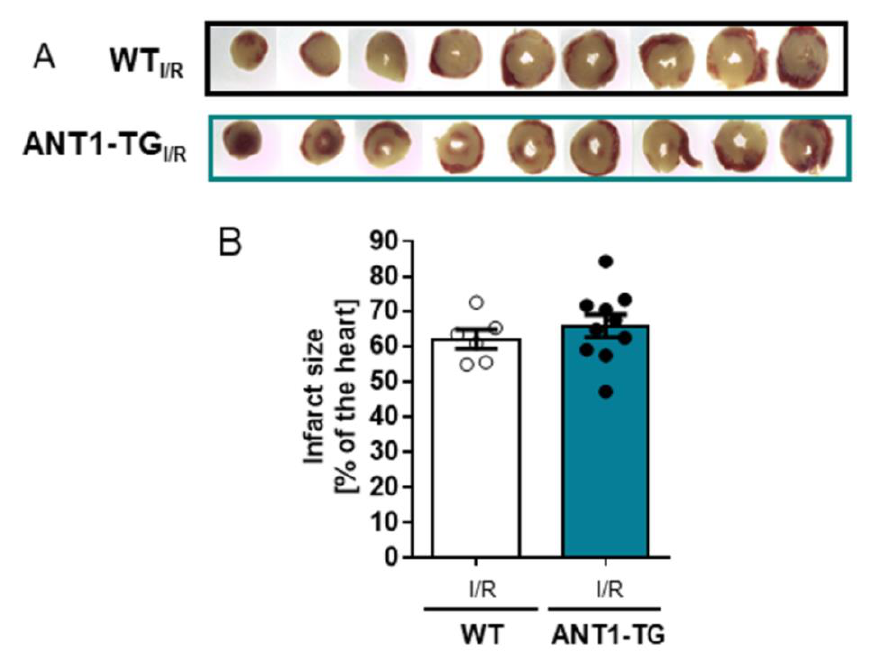
Figure 4. Determination of cell death in WT and ANT1-TG hearts after I/R ( A , B ) WT and ANT1-TG hearts were stained with TTC after I/R, and infarct sizes were measured as ratio to LV area (WT, n = 6; ANT1-TG, n = 10). ( A ) Representative images of one WT and one ANT1-TG heart, each with nine slices of the same heart. ( B ) Quantitative analysis of the infarct size after 45 min of ischemia, followed by two hours of reperfusion (I/R) from WT and ANT1-TG hearts. Data represent the mean ± SEM, * p < 0.05, using the one-way ANOVA.